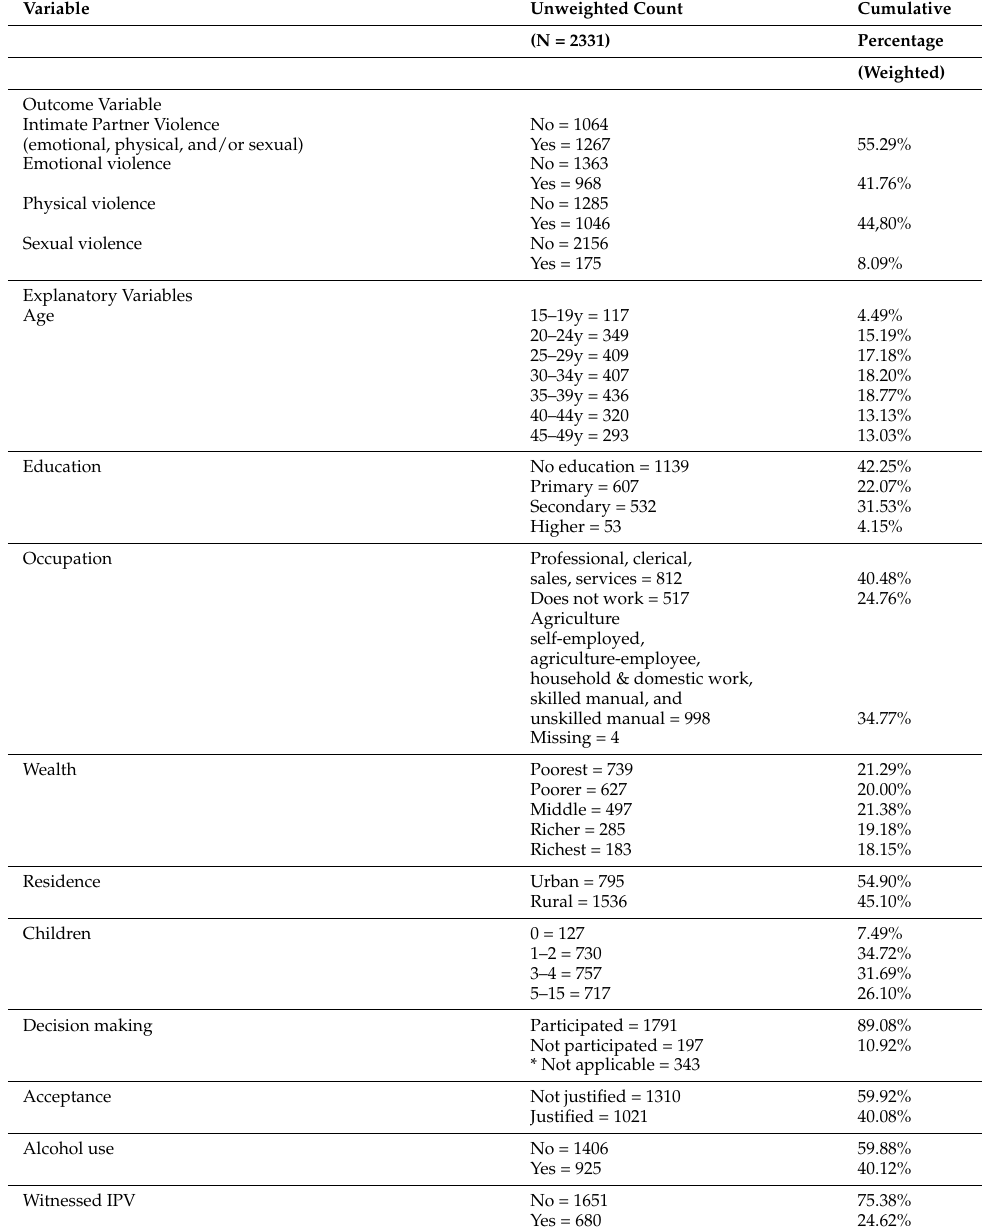
Table 1. Counts and proportions of study variables—Liberia DHS